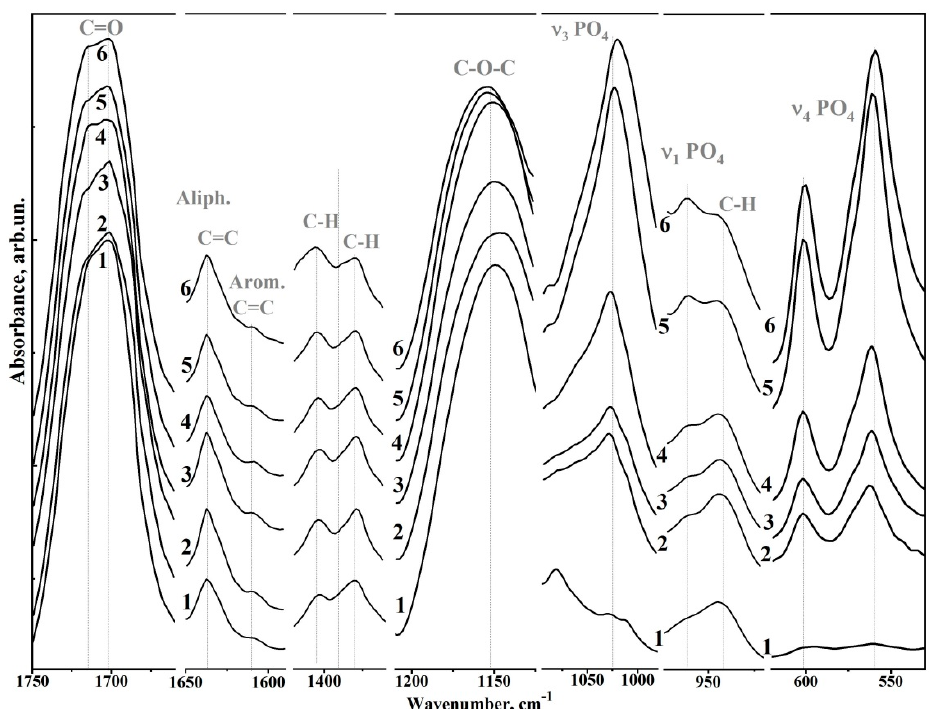
Figure 4. Spectral features of biomimetic adhesives. (1) Sample #6 Bis-GMA/nano-cHAp (0.01